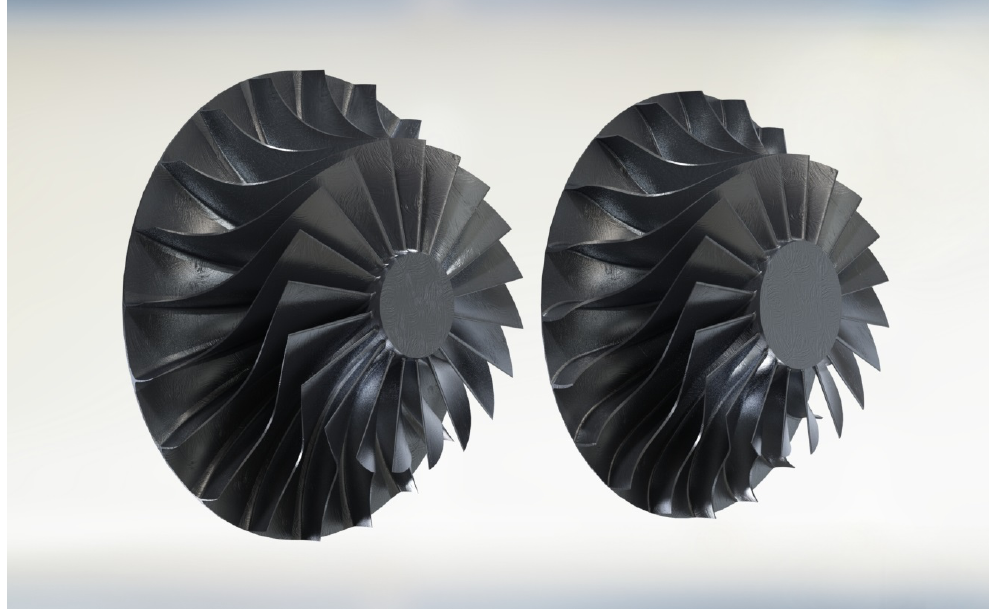
Figure 6. Studied compressor’s geometry: ( left ) Eckardt O; ( right ) Eckardt A.